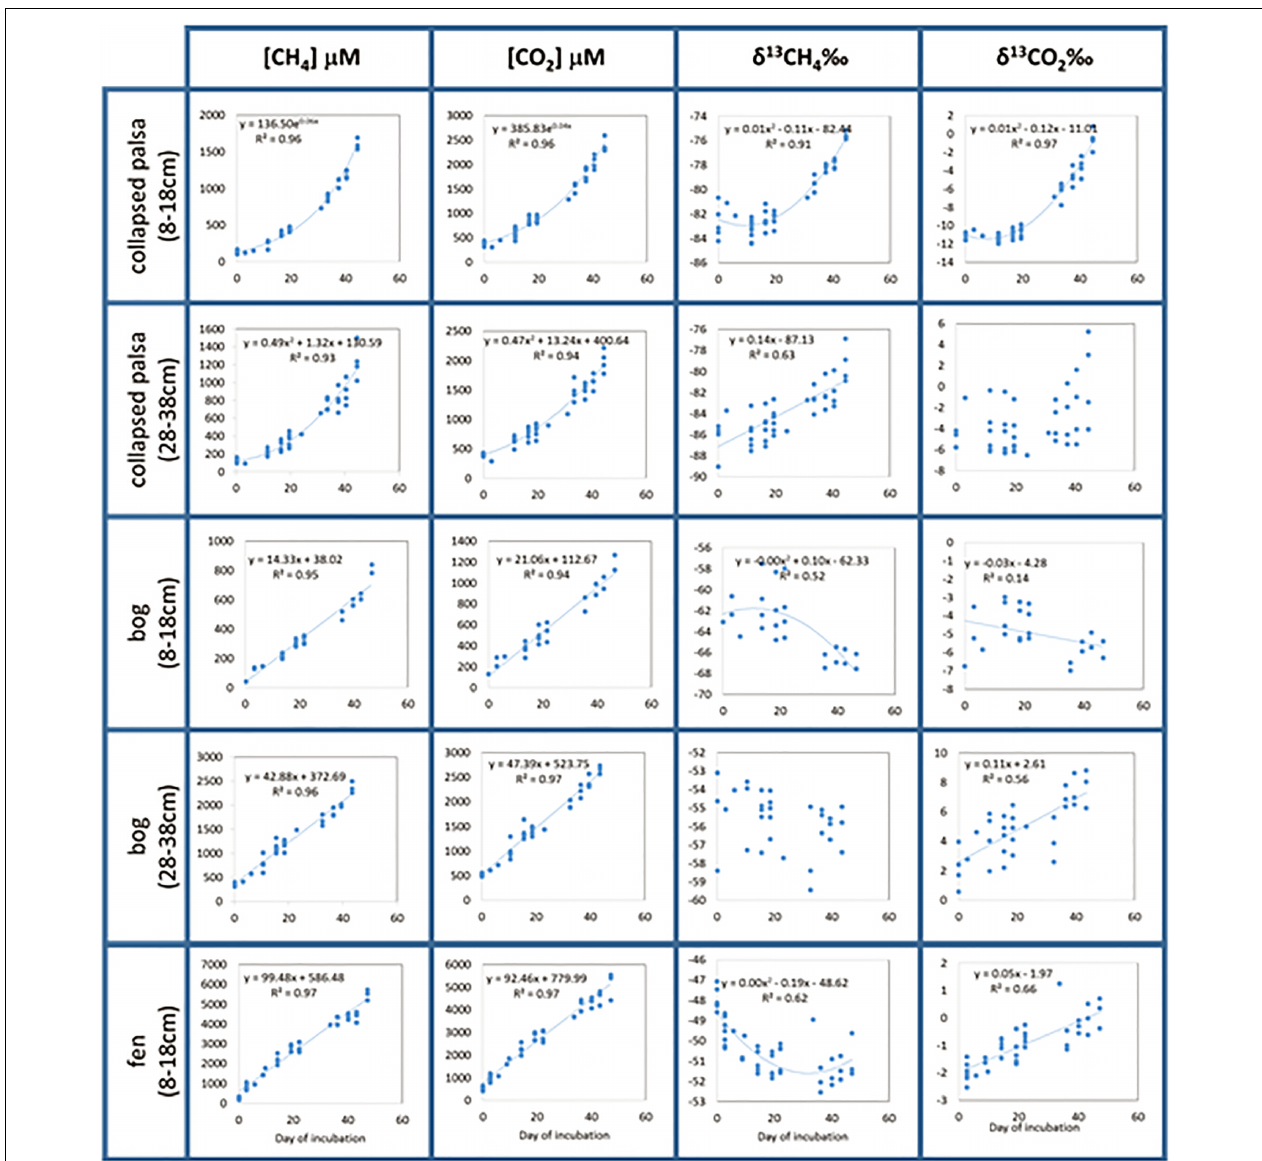
FIGURE 3 | Measured incubation data represented by points and regression equations (dotted lines) used as model input parameters. For the two cases where the isotopic signature of the emitted gas ( δ 13 CH 4 in bog deep and δ 13 CO 2 collapse palsa deep) did not change regularly with time [i.e., the regression equations explained less than 50% of the variability in the data ( R 2 < 0.5)], we used the average value of the data as the model input